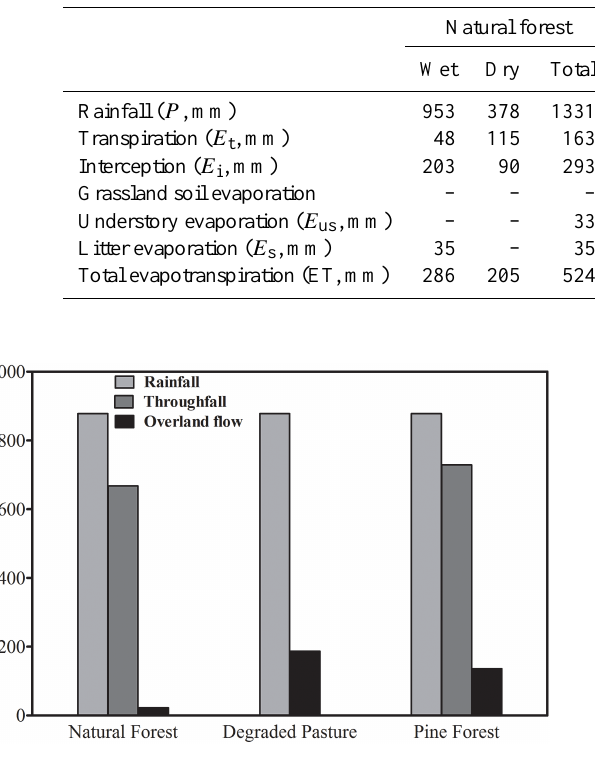
Figure 4. Amounts of rainfall, throughfall and overland flow (mm) during the 2011 monsoon measuring campaign (20 June–9 Septem- ber) in a natural forest, a degraded pasture, and a mature, intensively used pine plantation near Dhulikhel, central Nepal. Note that values for the natural forest plot were normalised for rainfall amount to allow for more direct